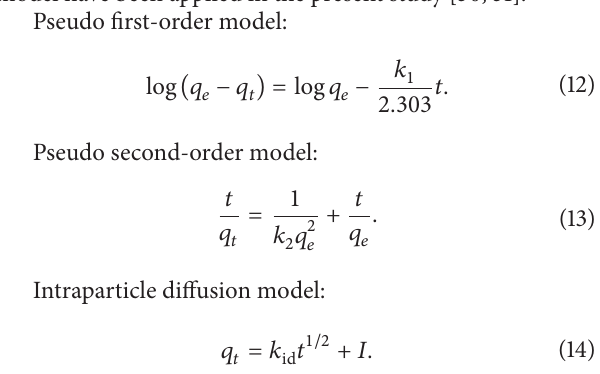
and pseudo second-order models and intraparticle diffusion model have been applied in the present study [50, 51].